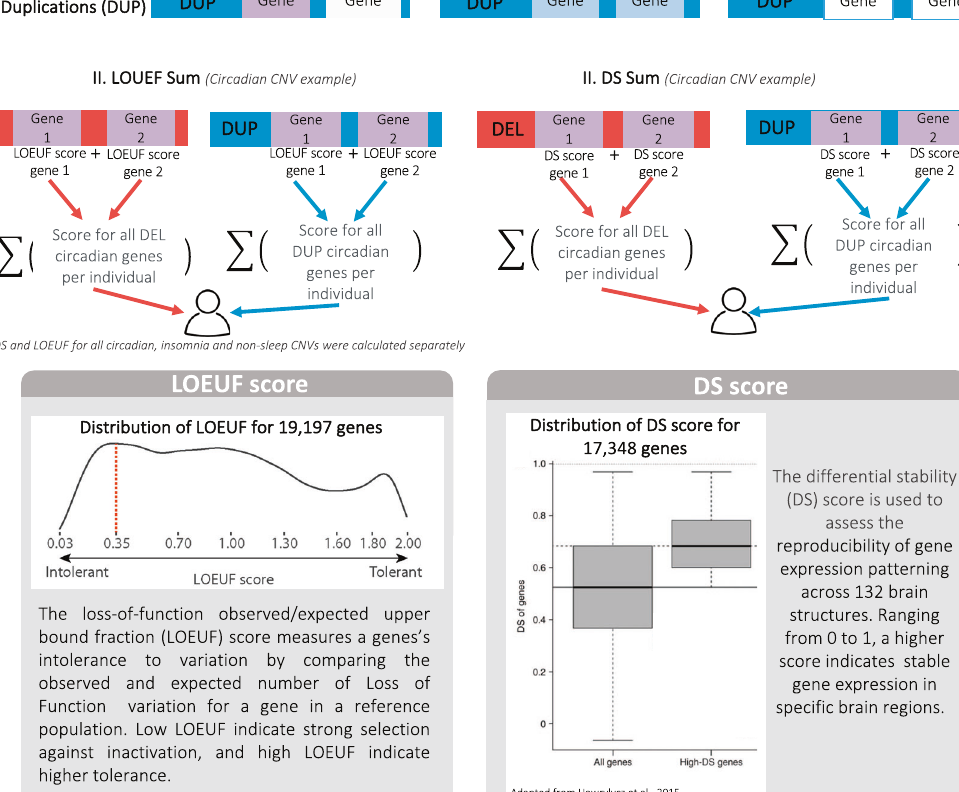
Fig. 1 Schematic of CNV selection. The fi gure describes the selection and annotation process of CNVs included in the study. CNVs were fi rst classi fi ed based on containing ‘ sleep genes ’ (circadian pathway or insomnia risk genes) or non-sleep genes. All genes encompassed within each CNV were then annotated to derive a sum of intolerance to haploinsuf fi ciency (LOEUF score) and a brain expression score (DS